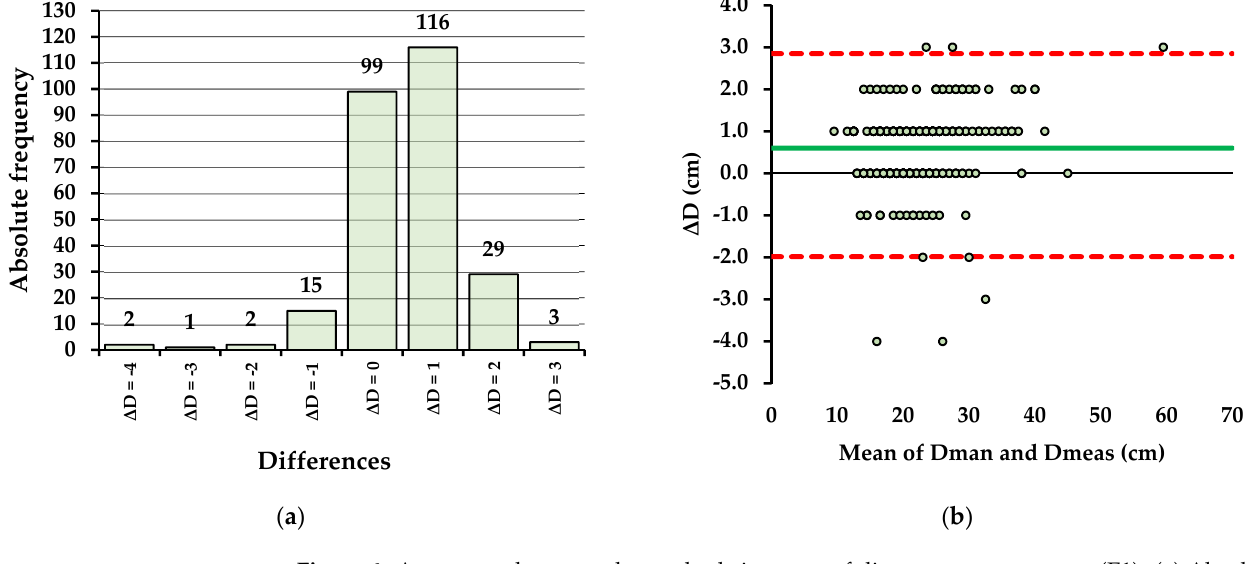
Figure 6. Agreement between the methods in terms of diameter measurement (E1): ( a ) Absolute frequency of differences ( Δ D) between Dman and Dmeas; ( b ) Bland-Altman plot showing the differences plotted against the mean of paired measurements, the bias (green line), and the lower and upper limits of agreement (red dashed lines).